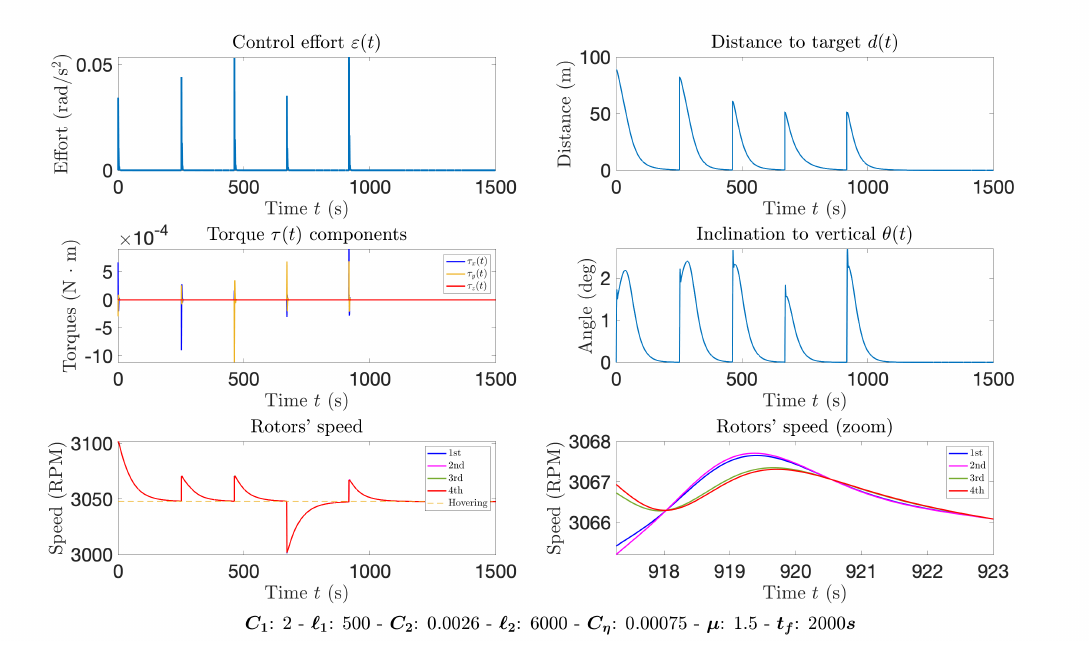
Figure 15. Experiment: Targets shifting randomly in time, first set of VARP parameters. ( a ) Target approaching trajectory; ( b ) Control figures.